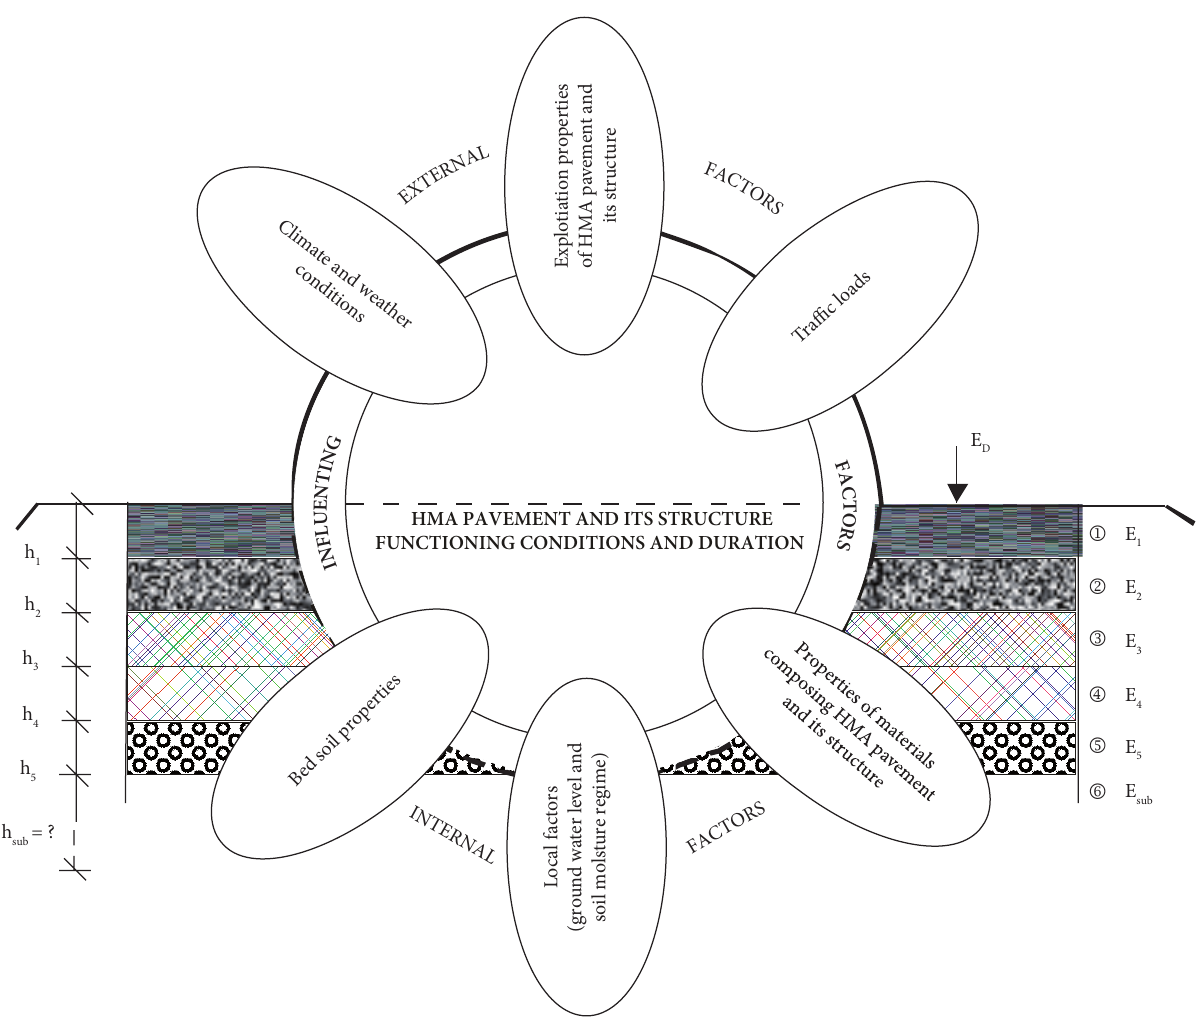
Fig. 1. Model of interdependence between the factors predetermining HMA pavement and its structure functional conditions and duration: j – n – HMA pavement structure layers ( j and k – upper and lower layers of HMA pavement; l and m coarse aggregate (CA) or gravel road bed layers; n – frost blanked course from sand (S) or other material; o – subgrade; E h – h – respectively, resilient modules of the indicated HMA pavement structure layers and thickness of these layers; E 1 5 h – respectively, resilient module of subgrade and equivalent thickness of active sub